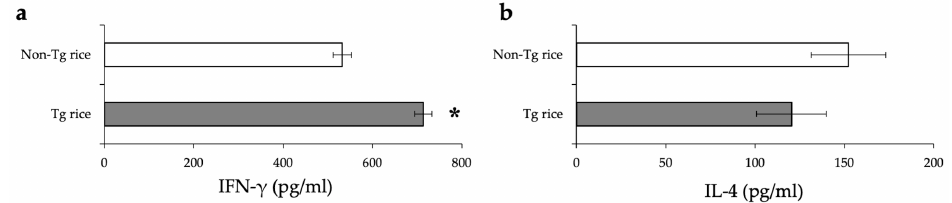
Figure 7. The release of IFN- γ ( a ) and IL-4 ( b ) by the antigen-stimulated splenocytes from mice fed with Tg or non-Tg rice. Data are means ± SEM. * p < 0.05, Tg vs. non-Tg rice-fed group according to unpaired Student’s t test (three mice per group). Table 2. Number of CD4+CD25+Foxp3+ Treg cells in mice fed Tg rice or non-Tg rice.